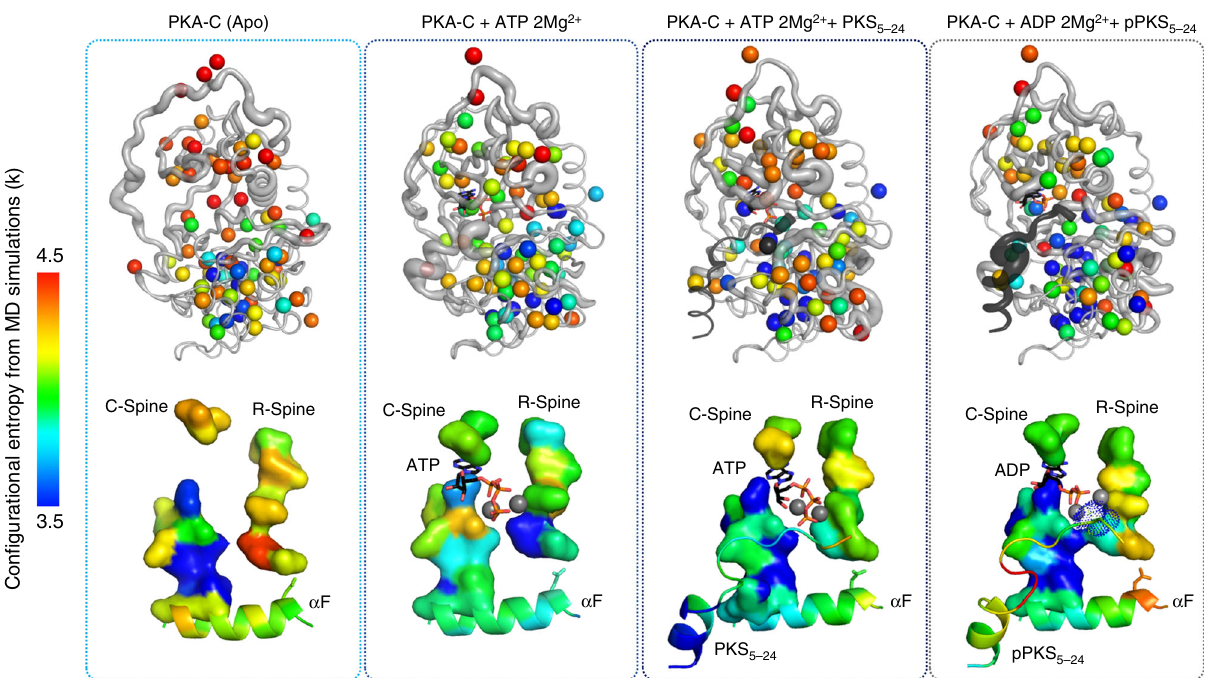
Fig. 4 Conformational entropy analysis of PKA-C based on MD simulations. Conformational entropy analysis of the main chain and side chains of the Apo, ATP, ATP + substrate and the ADP + phospho-product forms of PKA-C. The altered entropy of the enzyme upon binding ATP primes the enzyme for substrate binding, whereas the change of entropy in the ADP + phospho-product state primes the enzyme for product release. Changes in entropy are distributed globally through the